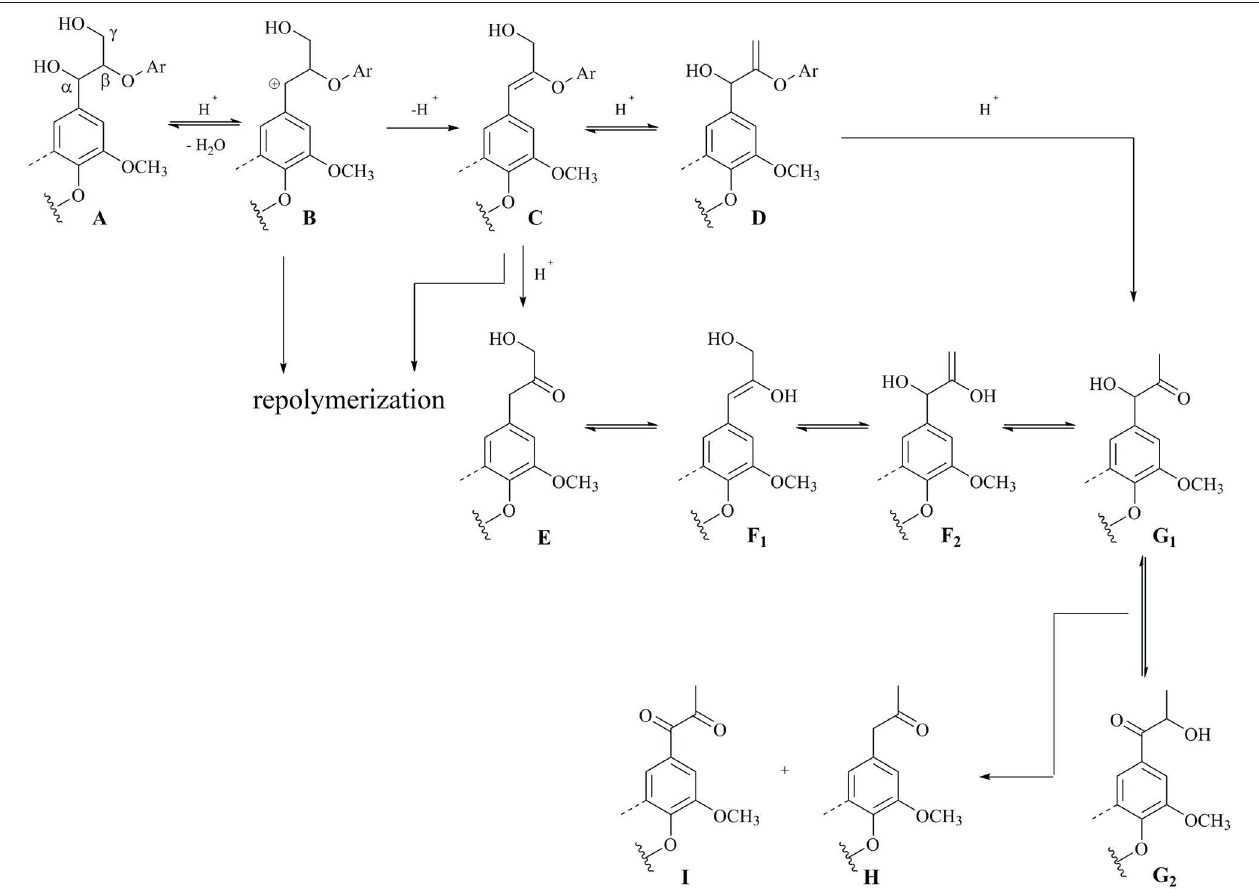
FIGURE 6 | Possible reaction pathway of deep eutectic solvent (DES)-treated lignin.